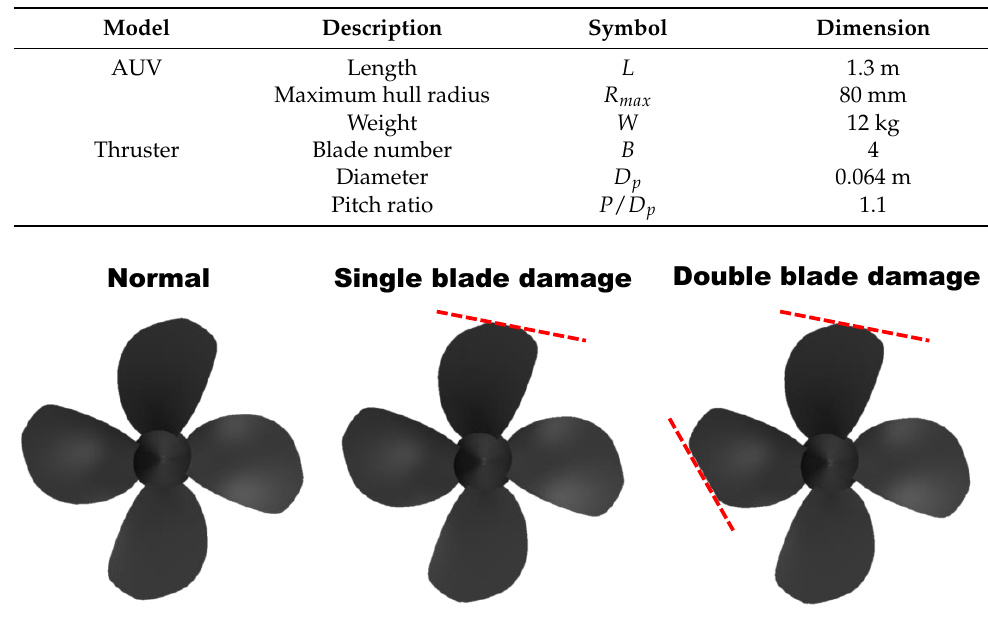
Figure 2. Configuration of thruster fault types. ( left ) Normal; ( middle ) single-blade damage; ( right ) double-blade